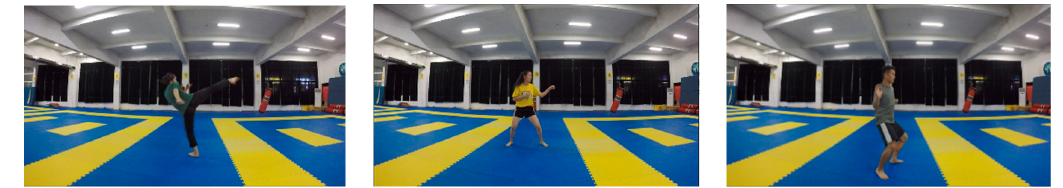
Figure 7. A frame of images corresponding to three types of actions in the